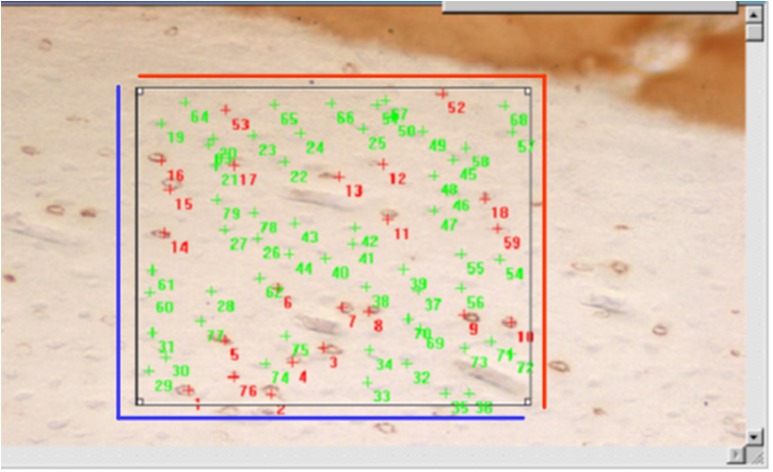
The image of previously standardized “Box” was included in the captured image to quantify the marked (in red) and unmarked (in green) cells.